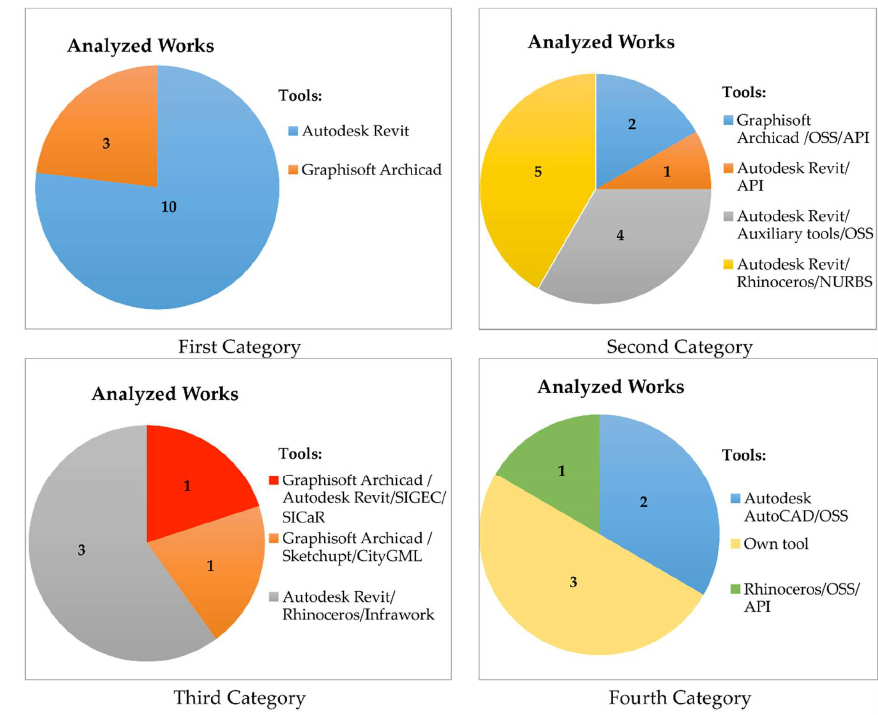
Figure 5. Categories classification. Source: Own figures.